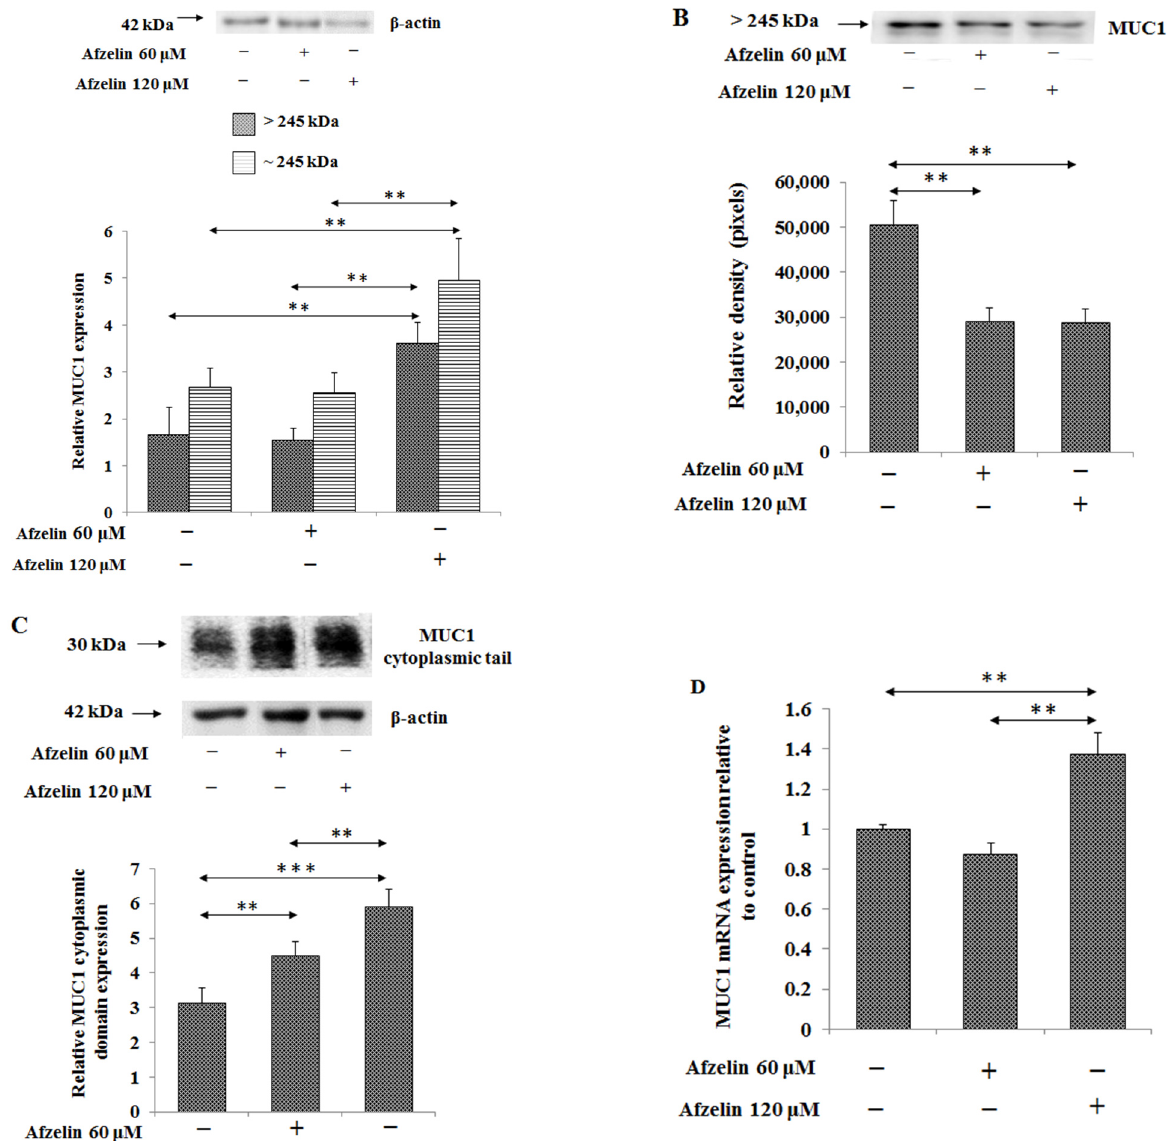
Figure 6. Effect of afzelin on MUC1 mucin expression in AGS gastric cancer cells treated with 60 and 120 µ M afzelin. Extracellular domain expression of MUC1 was measured using Western blot analysis in cell lysates ( A ), culture medium ( B ), and cytoplasmic tail in cell lysates ( C ). β -actin expression served as protein loading control. The bands intensity was quantified by densitometry analysis. Data are presented as the mean ± SD from 3 assays. ** p < 0.01; *** p < 0.001. MUC1 gene expression was determined by RT-PCR ( D ). The results are shown as a relative fold change in MUC1 mRNA in comparison to the control where expression was set as 1. ± SD are the mean of triplicate cultures. ** p < 0.01.